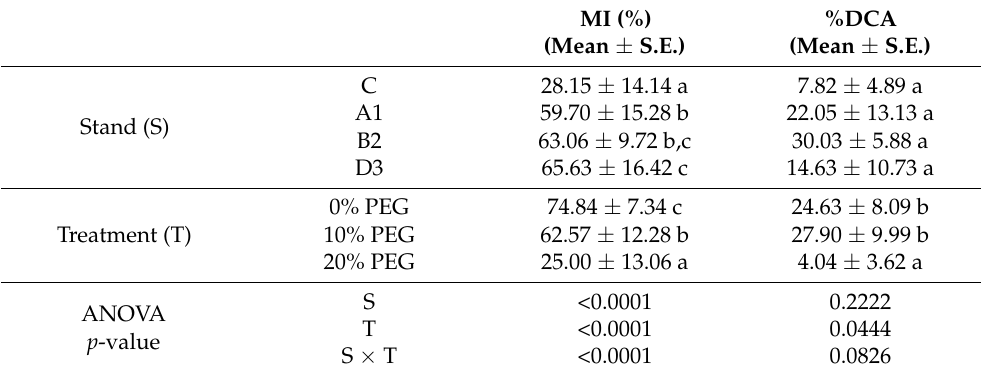
Table 4. Mean ( ± S.E.) percentage values of mitotic index (MI) and dividing cells with anomalies (DCA) determined per stand (S), PEG treatment (T), and for their interaction (S × T).